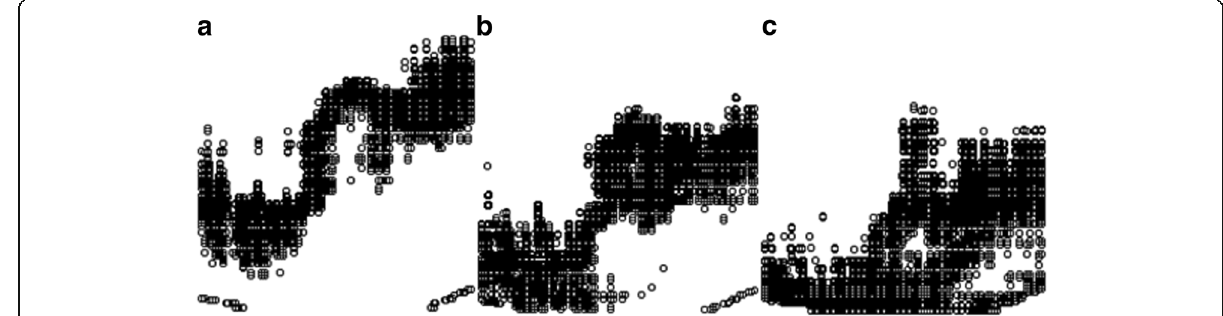
Fig. 2 Three-class label observation of middle-layer data from knuckle image. From left to right is a , b , and